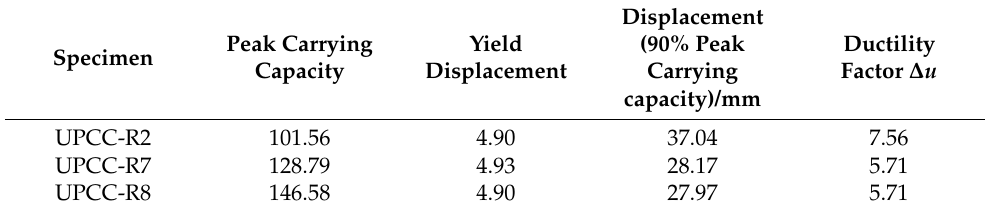
Table 13. The ductility coefficient of specimens under EREDL with different thickness.